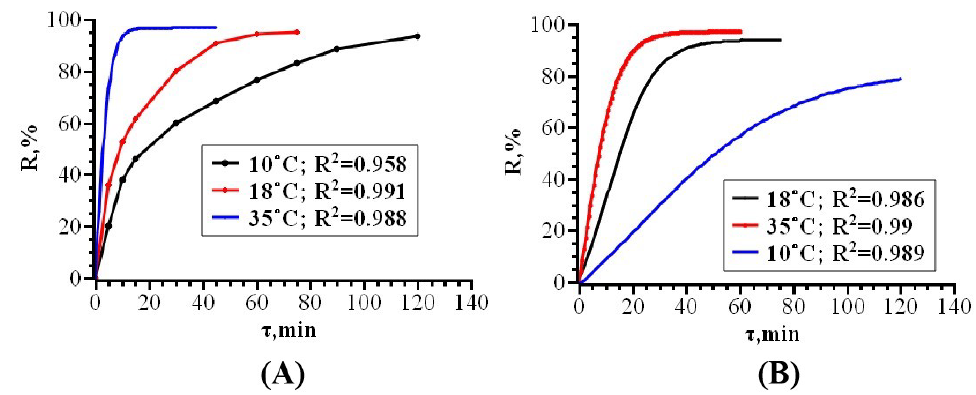
Figure 5. Dependence of removal efficiency on time at different temperatures: ( A )—CR, ( B )—MB. The resulting product of the SPE of CR and the synthesized sorbent luminesces in